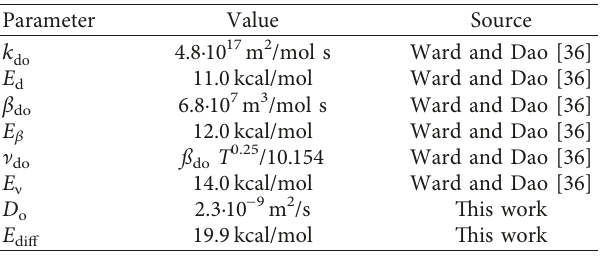
Table 2: Summary of hydrogen transport parameter values used in model